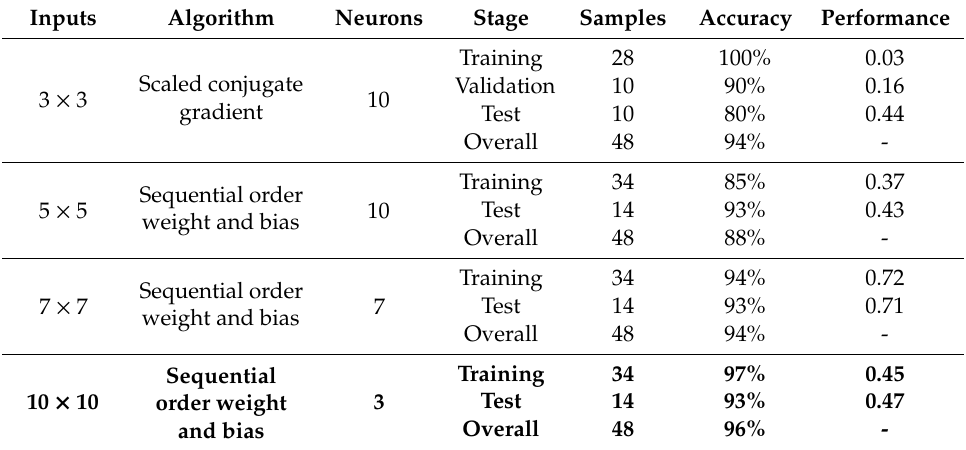
Table 2. Best pattern recognition model developed for each set of inputs showing the best training algorithm and number of neurons to predict whether canopies are smoked or non-smoked (control). Inputs corresponds to data extracted from infrared thermal images for T canopy , I g and crop water stress index (CWSI) in matrix arrangement of 3 × 3 ( n = 27), 5 × 5 ( n = 75), 7 × 7 ( n = 147) and 10 × 10 ( n = 300) data points per thermography. Performance reported is based on cross-entropy.